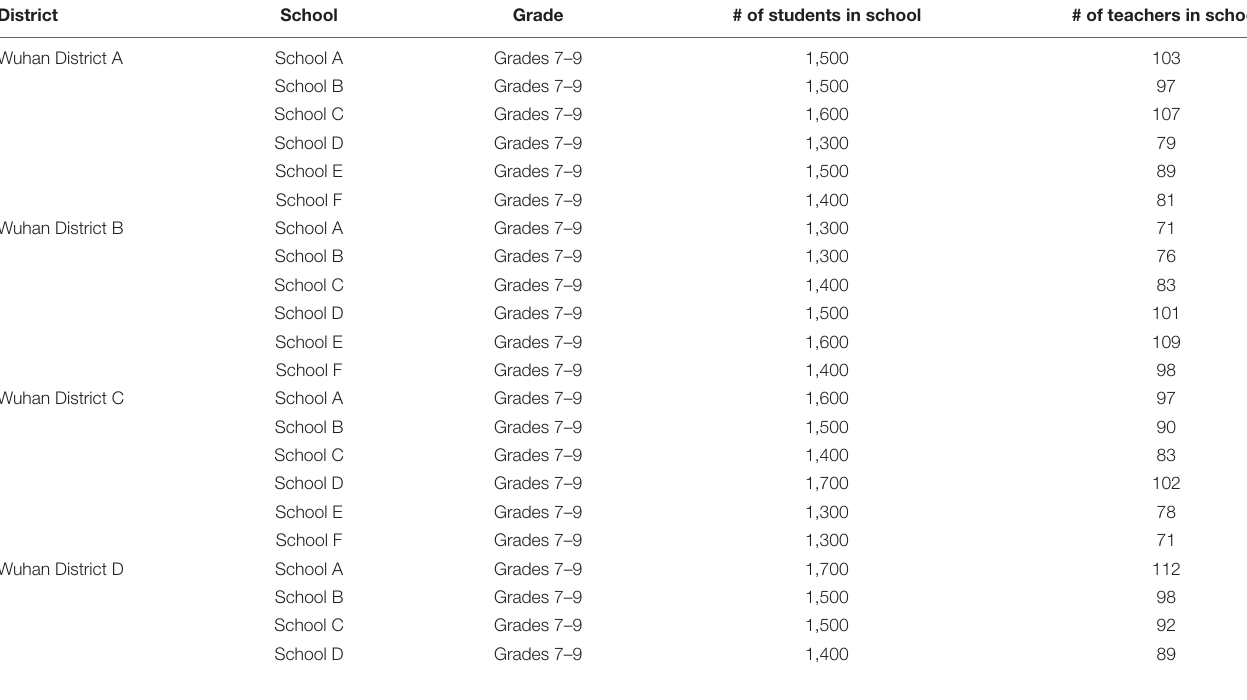
TABLE A1 | Profiles of 22 public schools involved in the